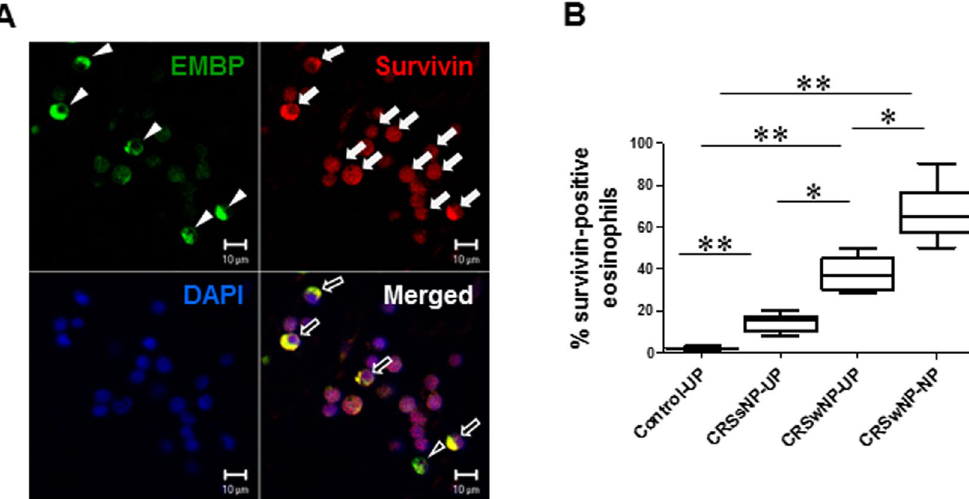
Figure 4. Double immunofluorescence micrographs of EMBP and survivin expression in human NP tissue. ( A ) EMBP-positive cells (arrowheads) support survivin expression. Survivin protein (white arrows) was dominantly expressed in the cell cytoplasm, unlike in the nucleus. ( B ) Percentage of survivin-positive eosinophils (black arrows) was significantly greater in the NP tissue. Data are expressed as the means ± SD. * P < 0.05 , ** P < 0.01. Mann-Whitney U test. Scale bar = 10 μ m.